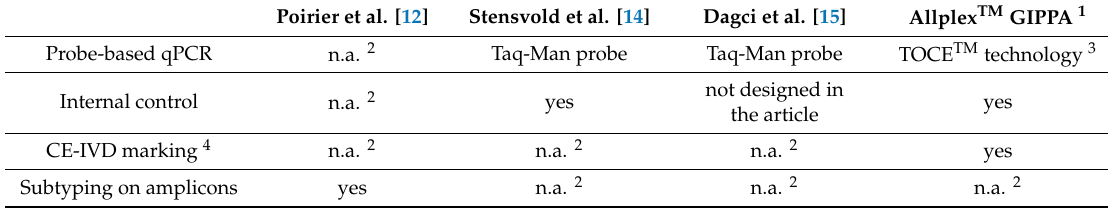
Table 2. Summary of important characteristics of the four qPCR assays tested.